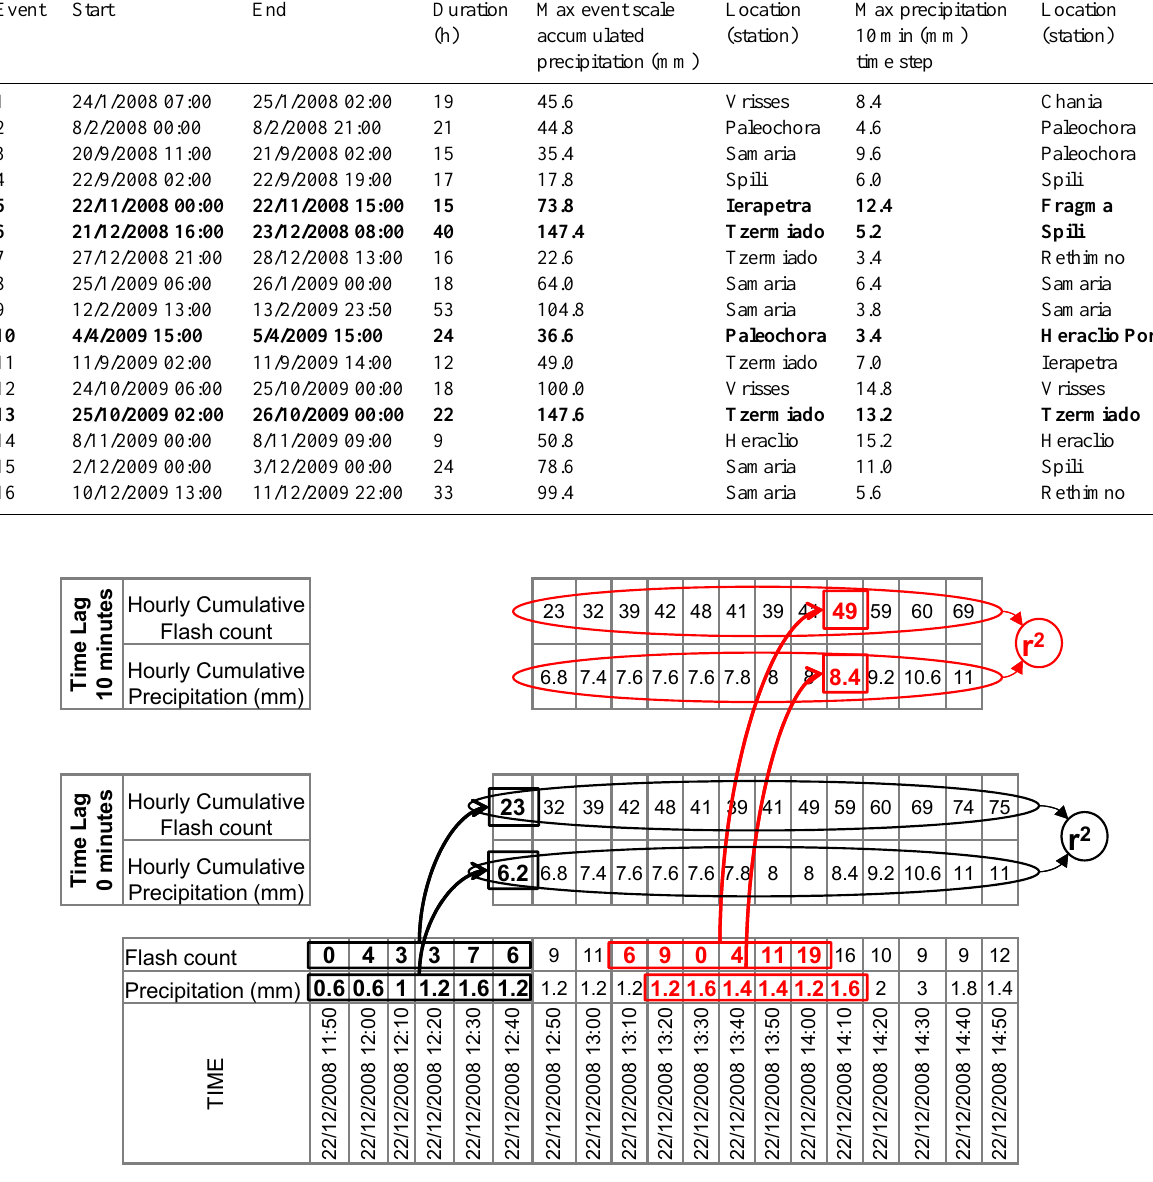
Table 1. List of intense precipitation events selected for analysis and corresponding event characteristics (duration, value and location of maximum recorded accumulated precipitation, value and location of maximum 10min precipitation, value and location of maximum 10min rain rate and location). Flood events marked in bold.